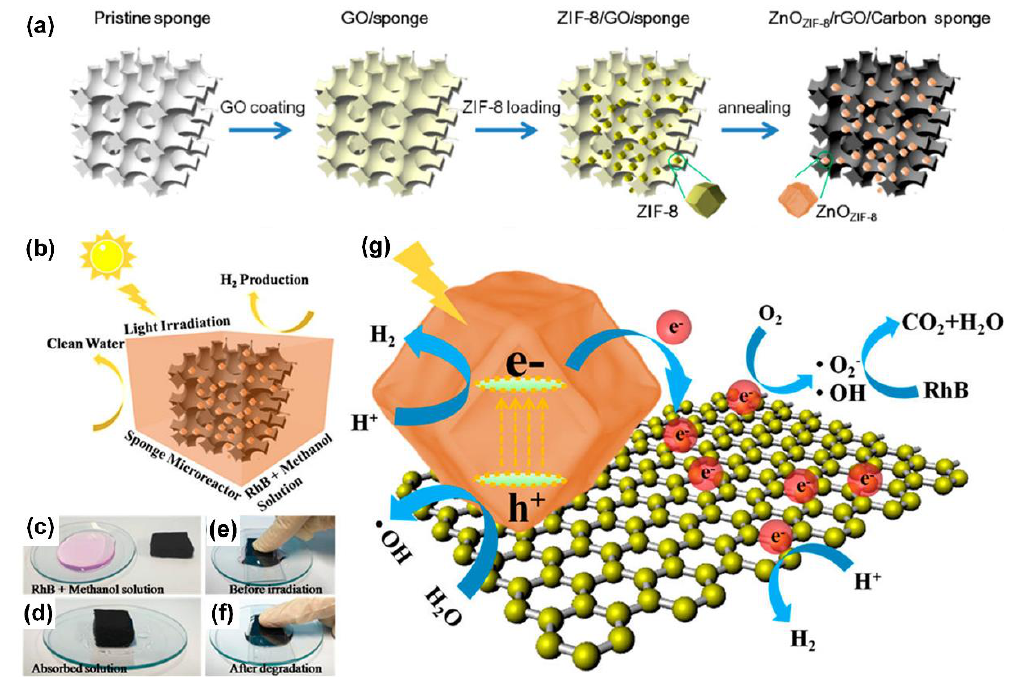
Figure 11. ( a , b ) Schematic illustration of the fabrication process and photocatalytic reaction in ZnO nanocages / rGO / carbon sponge (ZRCs)-based microreactor. ( c – f ) ZRCs absorption and in-situ photocatalytic degradation of RhB / methanol aqueous solution. ( g ) Schematic illustration demonstrating the mechanism of simultaneous sunlight-driven photocatalytic degradation of RhB and H 2 production. Adapted with permission from Reference [167]. Copyright (2018) American Chemical Society. Table 1. Summary of representative carbonaceous photocatalysts synthesis approaches, and their applications.